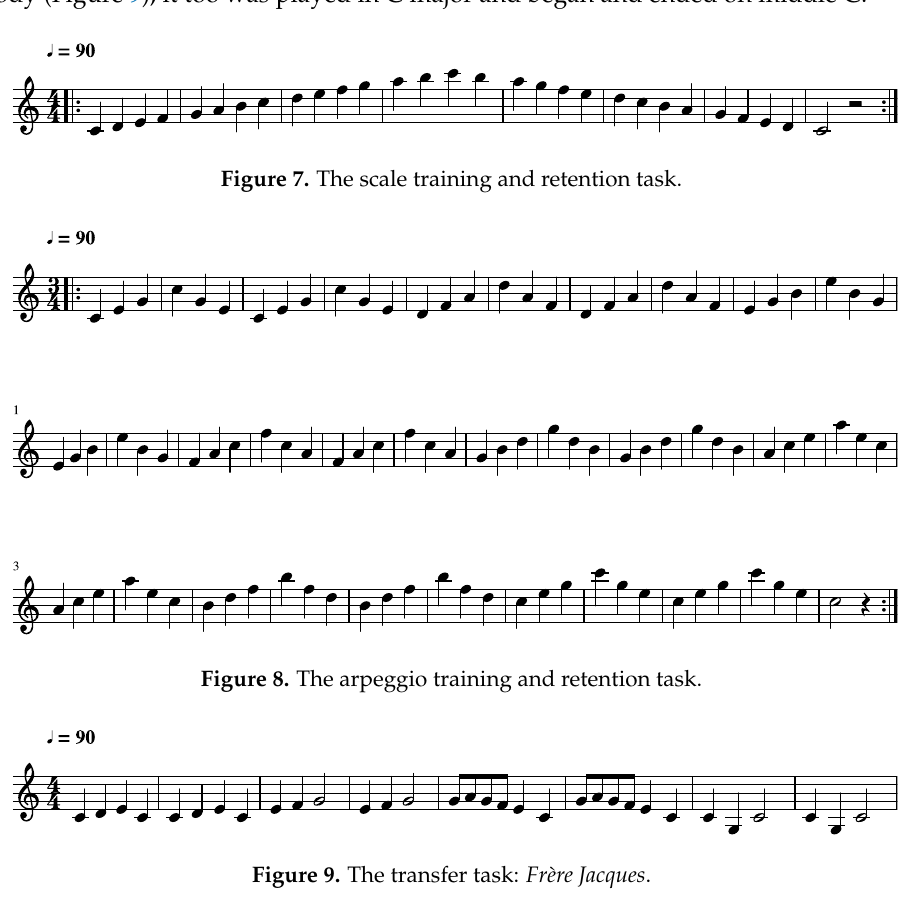
Figure 9. The transfer task: Frère Jacques